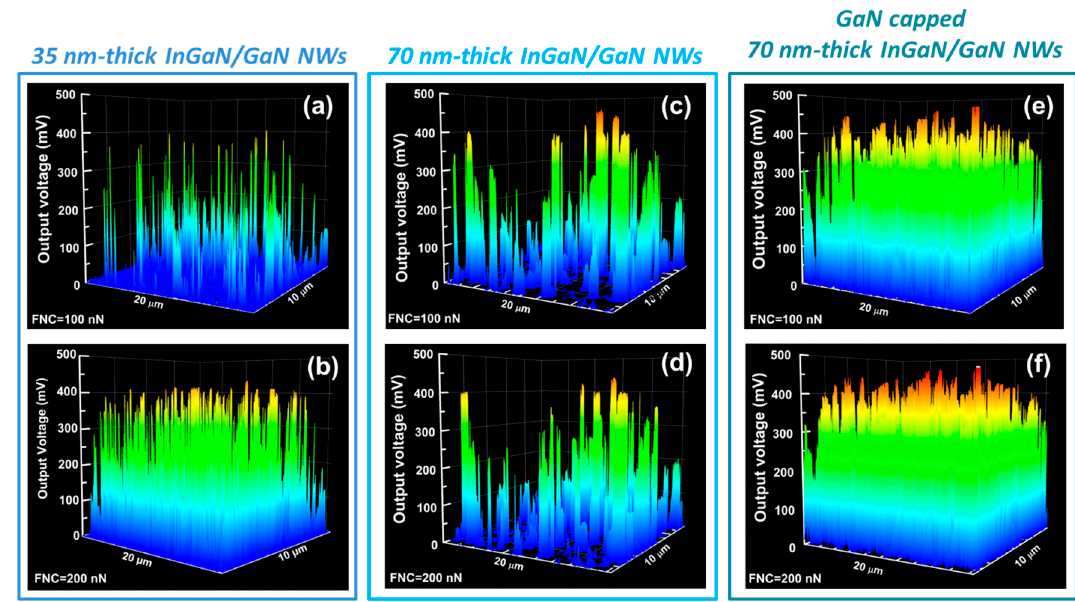
Figure 3. 3D output voltage mappings collected on ( a , b ) 35 nm-thick InGaN/GaN; ( c , d ) 70 nm-thick InGaN/GaN; and GaN capped 70 nm-thick InGaN/GaN NWs ( e , f ) using an AFM equipped with a modified Resiscope module in piezo-generation configuration for two different constant normal forces of 100 and 200 nN.